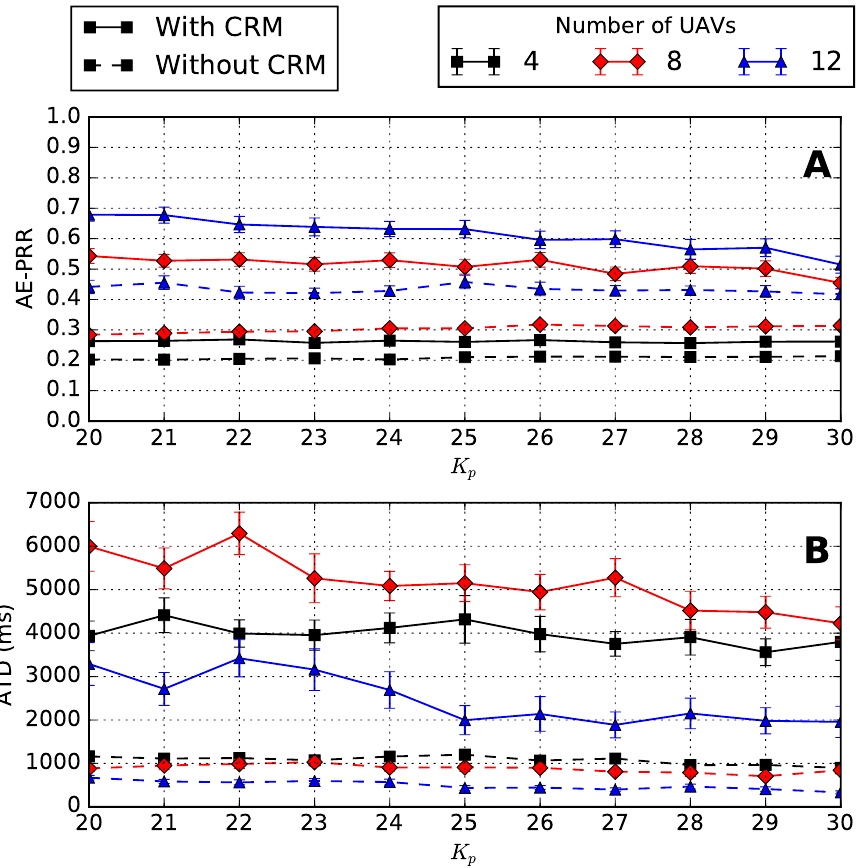
Figure 5. AE-PRR ( A ) and Average Total Delay (ATD) ( B ) comparison when the CRM algorithm is activated in a scenario with three teams of 20